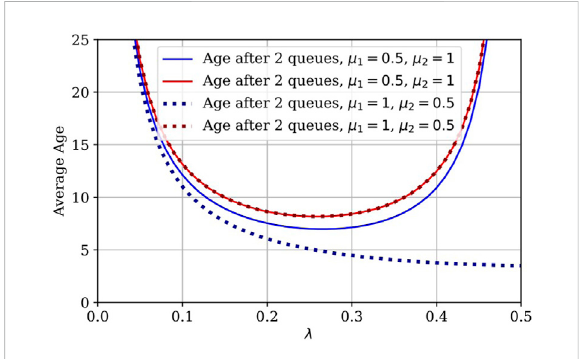
FIGURE 10 Average age vs. λ , μ = 1, in fi nite queue capacity. FIGURE 11